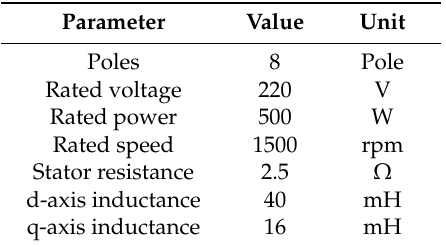
Table 2. Specifications of the SynRM.